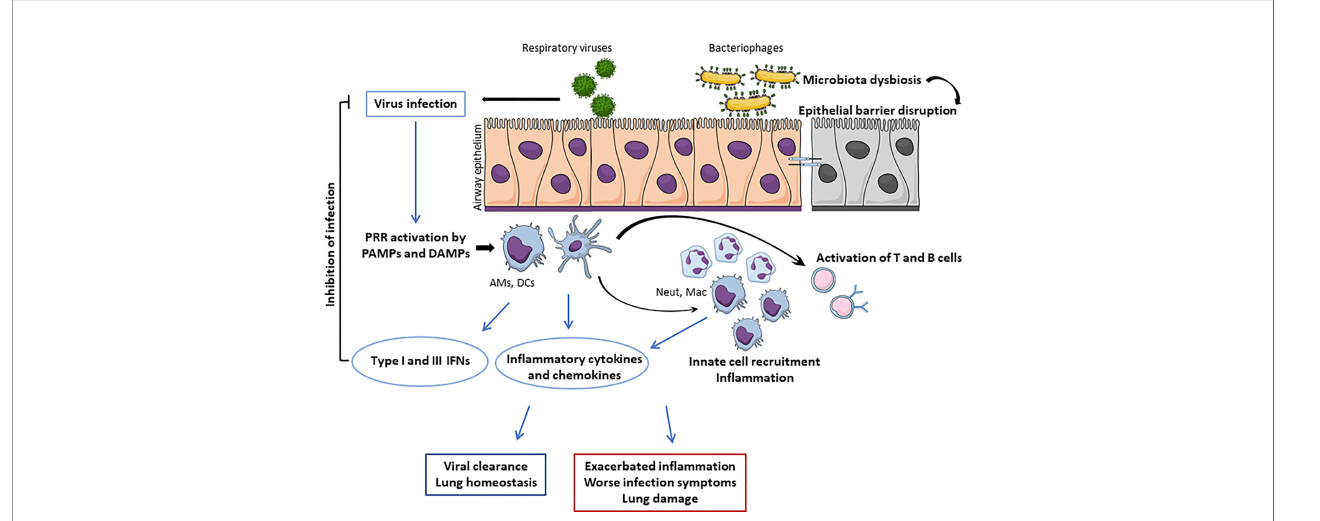
FIGURE 2 | Overview of bene fi cial and harmful roles of the lung virome during respiratory viral infections. Respiratory viruses are recognized by pattern-recognition receptors (PRR) expressed by both the airway epithelial cells and resident immune cells, such as alveolar macrophages (AMs) and dendritic cells (DCs). Once activated, AMs and DCs secrete pro-in fl ammatory cytokines and chemokines, which promote a local in fl ammatory response and the recruitment and activation of leukocytes, including neutrophils (Neut), and macrophages (Mac). Furthermore, AMs and DCs secrete type I and III interferons (IFNs), leading to virus clearance. Also, antigen-presenting cells, such as DCs, activate the adaptive immunity, mediated by T and B cells. This tightly controlled response leads to viral clearance and return to lung homeostasis. However, high lung viral loads along with microbiota dysbiosis and disruption of epithelial barrier can lead to an exacerbated in fl ammatory response, worsen infection symptoms, and ultimately lung damage. Figure created with